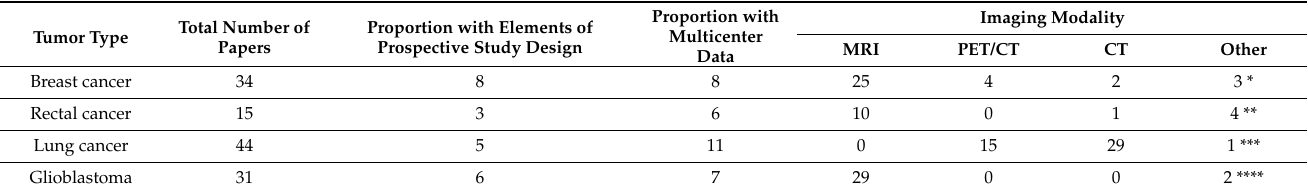
Table 1. Summary of imaging modality and study design (* = USS; ** = MRI and CT, n = 1; MRI and PET-CT n = 2; PET-MRI and CT n = 1; *** = Cone beam CT; **** = PET-MRI ( n = 1) and FET-PET ( n =